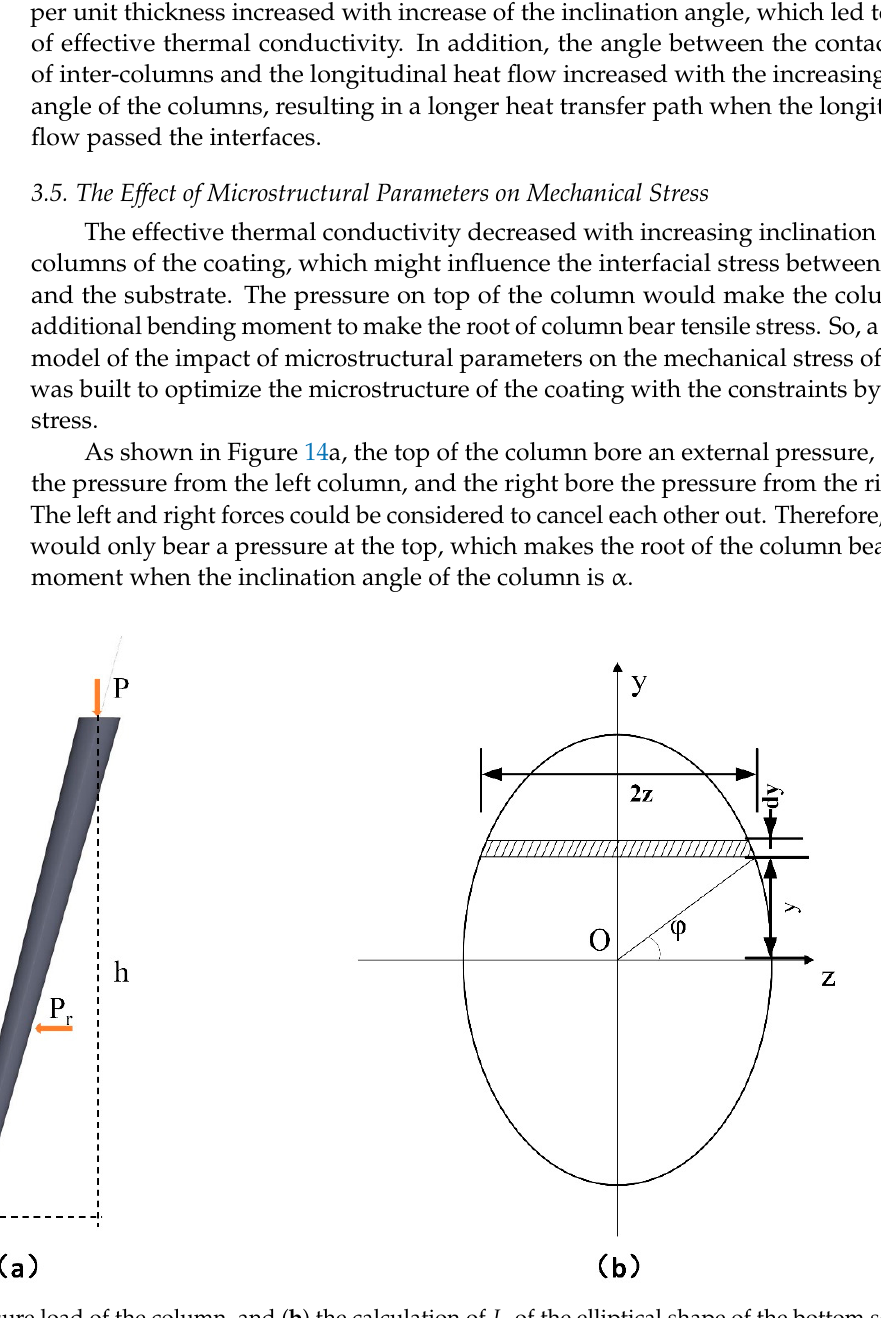
Figure 14. ( a ) The pressure load of the column, and ( b ) the calculation of I z of the elliptical shape of the bottom section. The computation of the normal stress at any point on the cross-sectional area of the root of column is shown in Equation (21), when the column is subjected to a bending mo- ment.